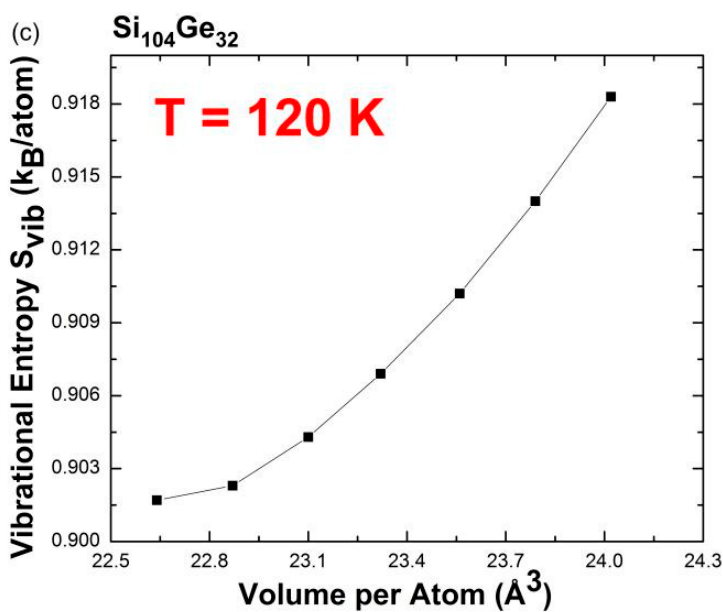
Figure 11. Predicted vibrational entropy as a function of the designated volume at ( a ) T = 40 K, ( b ) T = 60 K, and ( c ) T = 120 K for Si 104 Ge 32 .